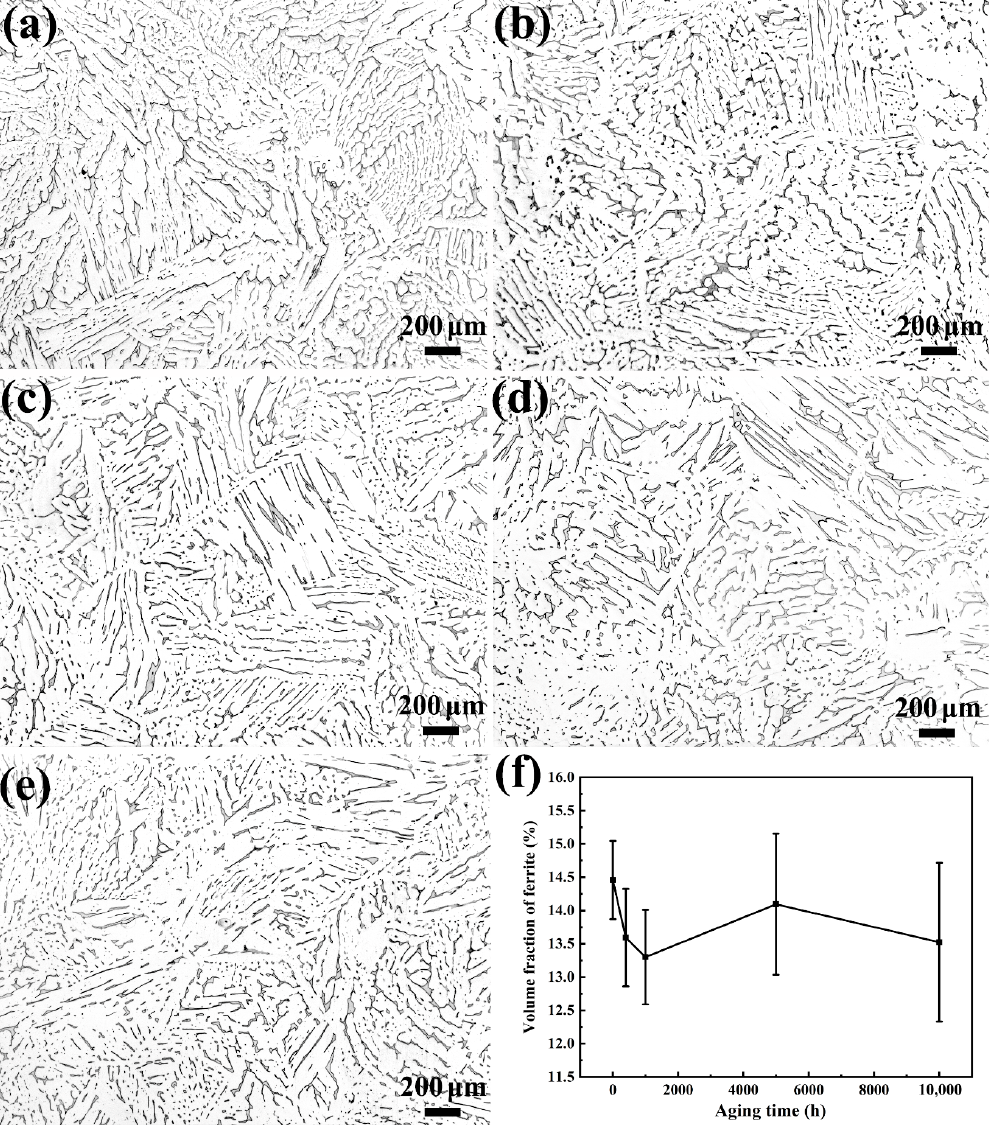
Figure 2. The metallographic microstructure and morphology of CDSS under the condition of thermal aging for ( a ) 0 h, ( b ) 400 h, ( c ) 1000 h, ( d ) 5000 h and ( e ) 10,000 h; ( f ) the corresponding volume fractions of ferrite at different aging times.